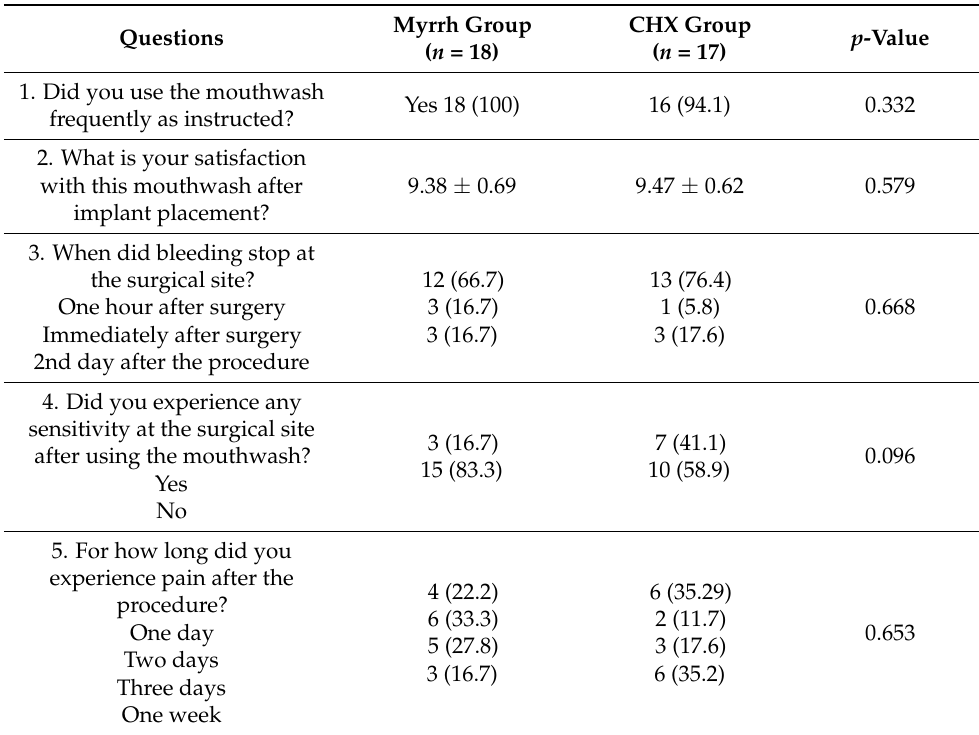
Table 2. Patient feedback questionnaire: questions and responses.